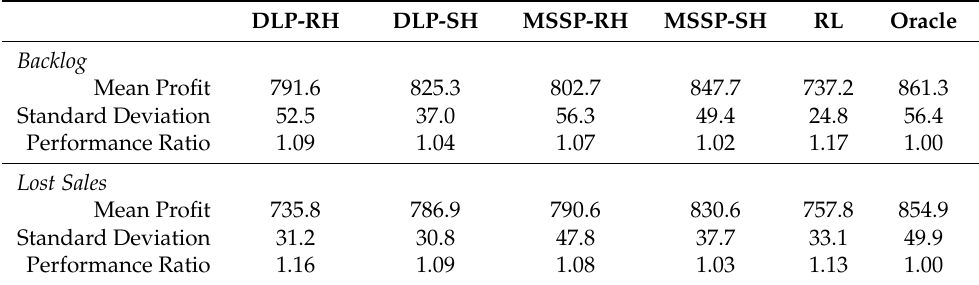
Table 2. Total reward comparison for the various models used to solve the IMP. Performance Ratio is defined as the ratio of the final cumulative profit of the perfect information model to that of the model used. DLP = Deterministic linear program; MSSP = Multi-stage stochastic program; RL = Reinforcement Learning; RH = rolling horizon; SH = shrinking horizon; Oracle = perfect information